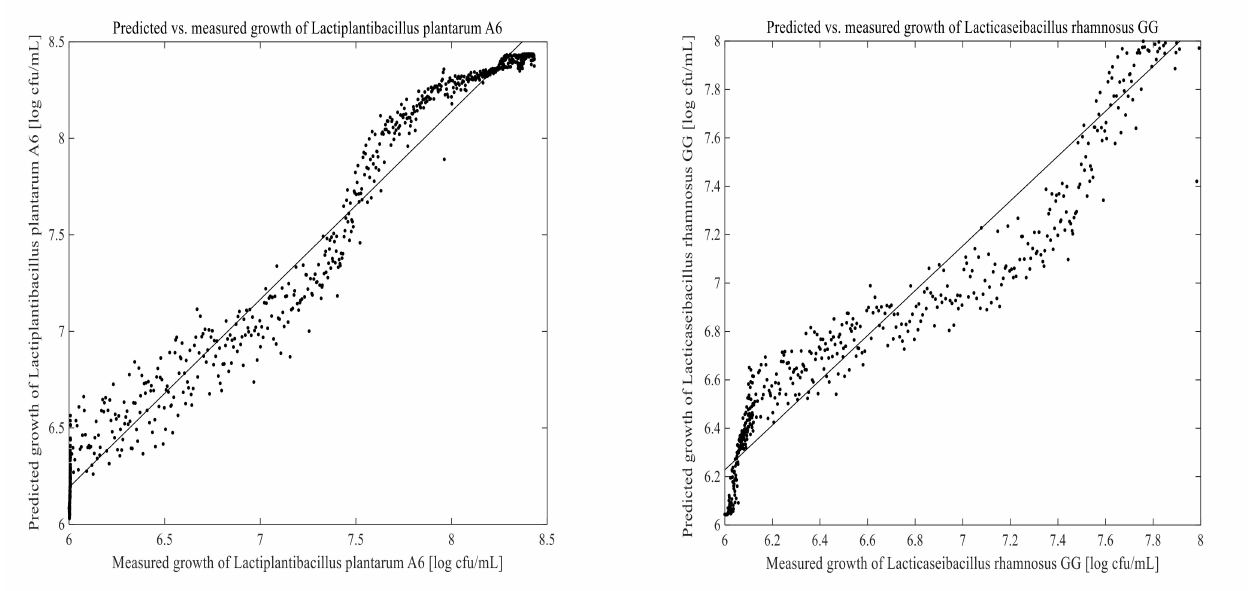
Figure 10. Predicted vs. measured cell growth in the fermentation of 7 g/100 mL of substrate inoculated with mixed strains of 6 log cfu/mL Lactiplantibacillus plantarum A6 and Lacticaseibacillus rhamnosus GG; predicted with artificial neural networks using five hidden neurons.